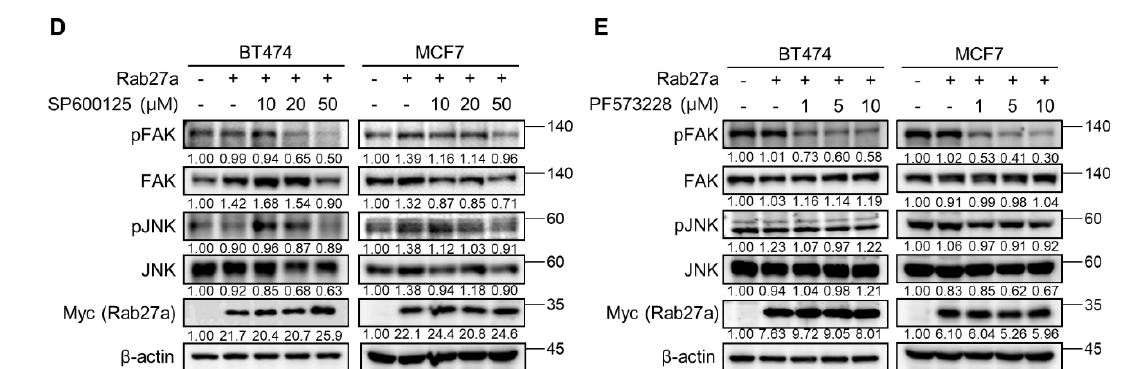
Figure 3. Rab27a overexpression promotes breast cancer cell migration. ( A ) BT474 and MCF7 cells were transfected with control or Rab27a expression vector. After 24 h, the cells were treated with 10 µM of BHMPS, and the percentage of migrated cells was determined. Statistically significant differences are shown in comparison with the Rab27a overexpression group. Representative images (40× magnification, Scale bars 250 µm) and means ± SD are from three independent experiments. ** p < 0.01 and *** p < 0.001 compared with Rab27a overexpression control. ( B ) BT474 and MCF7 cells were transfected with Rab27a-Myc-DDK expression vector. After 24 h, the cells were treated with the indicated concentrations of BHMPS for 24 h. The immunoblots show the expression of EMT-activating transcription factors. ( C ) Under the same experimental conditions as ( B ), FAK and MAPK signaling was determined by western blotting. ( D , E ) After 24 h of Rab27a overexpression, cells were treated with the indicated concentrations of JNK inhibitor (SP600125) or FAK inhibitor (PF573228) for 4 h. The uncropped images are shown in Supplementary Materials.